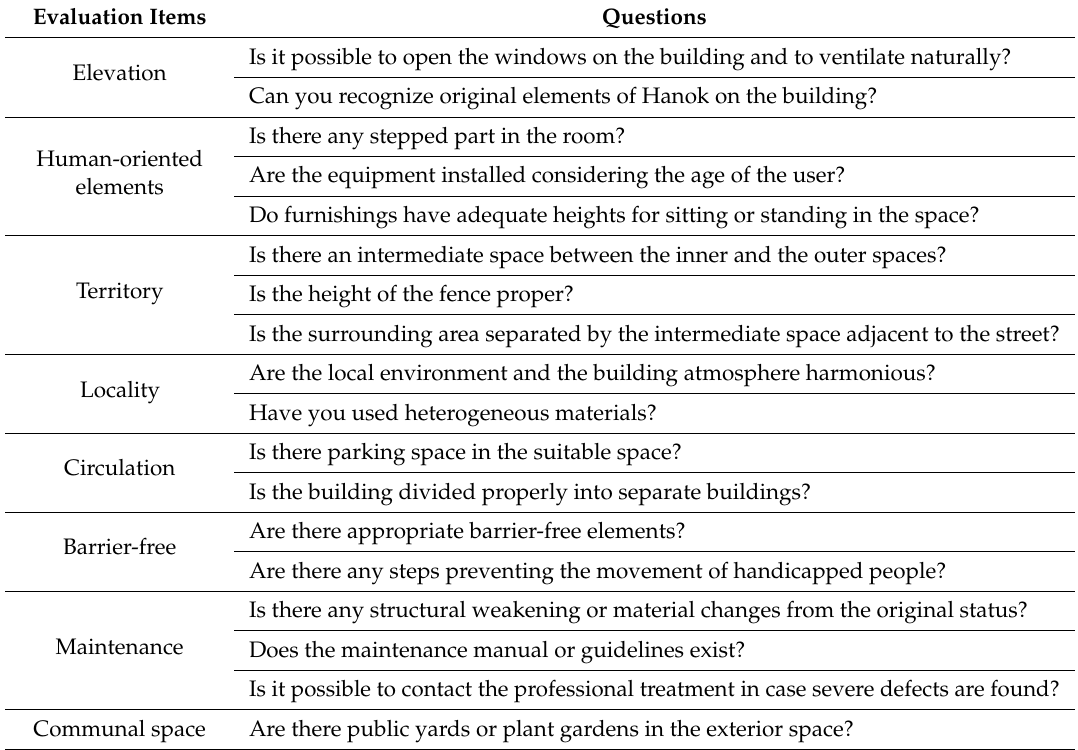
Table 5. Checklist for Hanok usability.